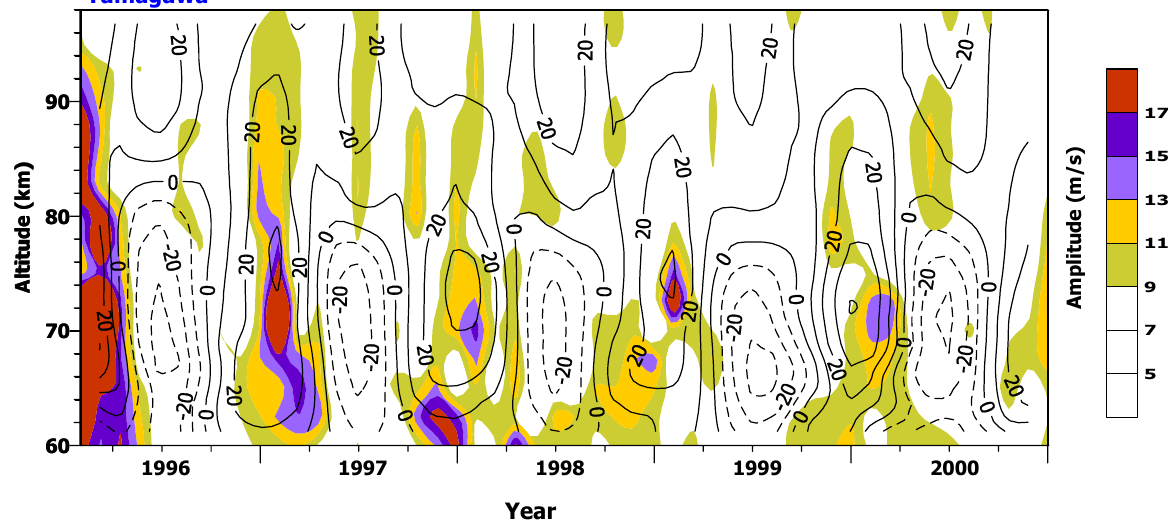
Fig. 4. Climatological presentation of the zonal 16-day waves (color scale) at Yamagawa during 1996–2000. The background wind is also shown in solid (eastward) and dashed (westward)